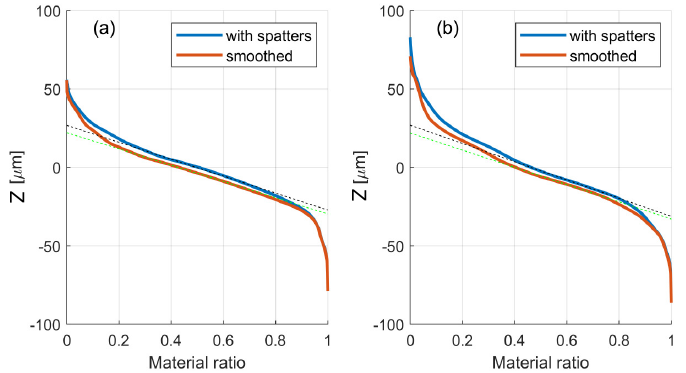
Figure 6. Material ratio curves from samples ( a ) 1 and ( b ) 19. Effect of removing spatters. The dashed line indicates the equivalent straight line.